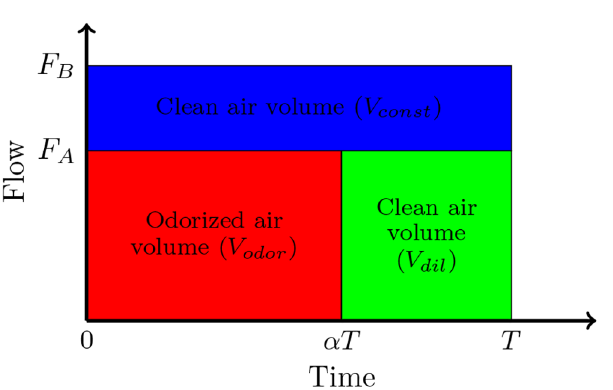
Fig 4. Representation of the volumes delivered during a T period. F A and F B correspond to the airflow managed by flowmeters A and B (Fig 2) respectively. In blue, the air volume due to the constant flow. In red and green, the volume of odor pulse and the volume required to keep a constant